Question: How would you classify this visualization?
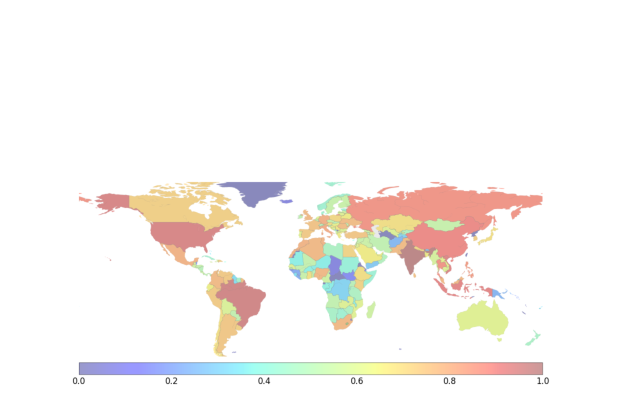
Answer: heatmap